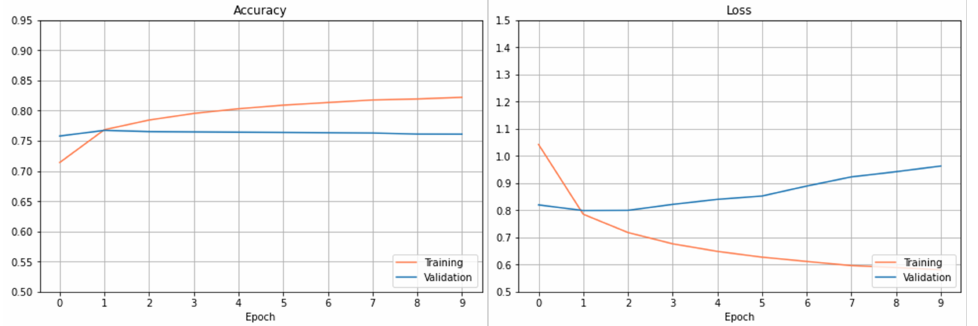
Figure 4. Training and validation results using the RNN-based architecture. ( Left ): Accuracy vs. epochs; ( Right ): Loss vs. epochs.